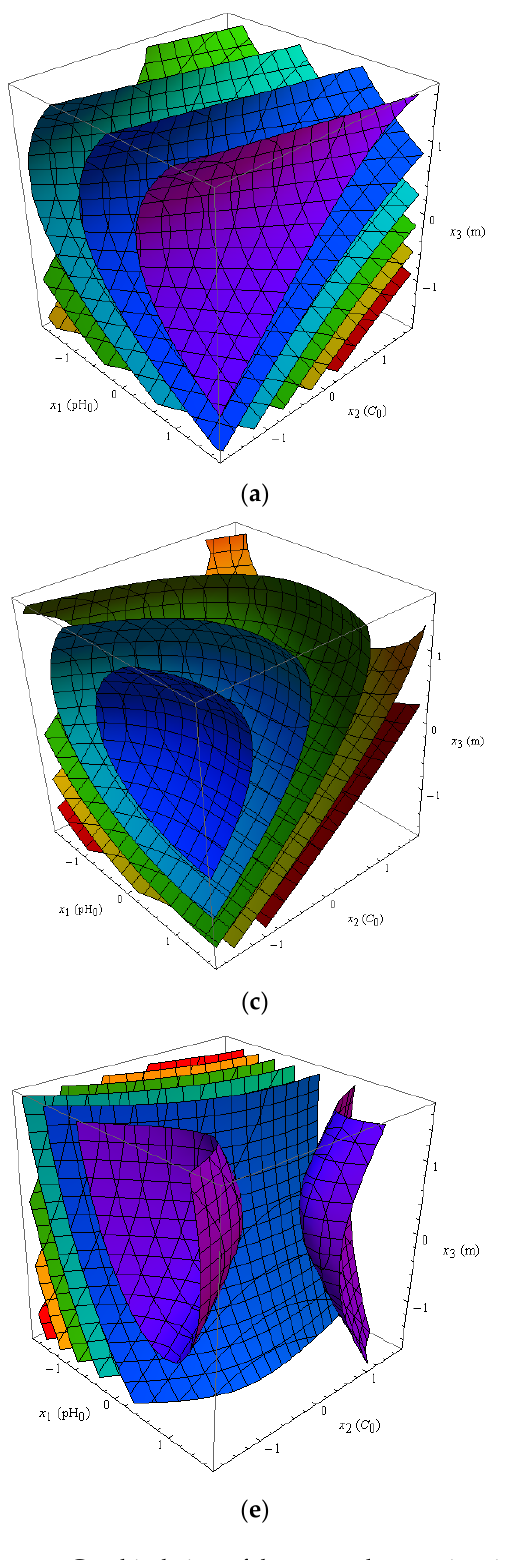
Figure 8. Graphical view of the removal approximation: surfaces of constant 𝑅(cid:3560) for Zn(II) ( a ), Ni(II) ( c ), and Pb(II) ( e ), and contour plots of 𝑅 for Zn(II) ( b ), Ni(II) ( d ), Pb(II) ( f ); color scale for figures a, c, e: red—75%; yellow—80%; green—85%; cyan—90%; blue—95%; magenta—100%.